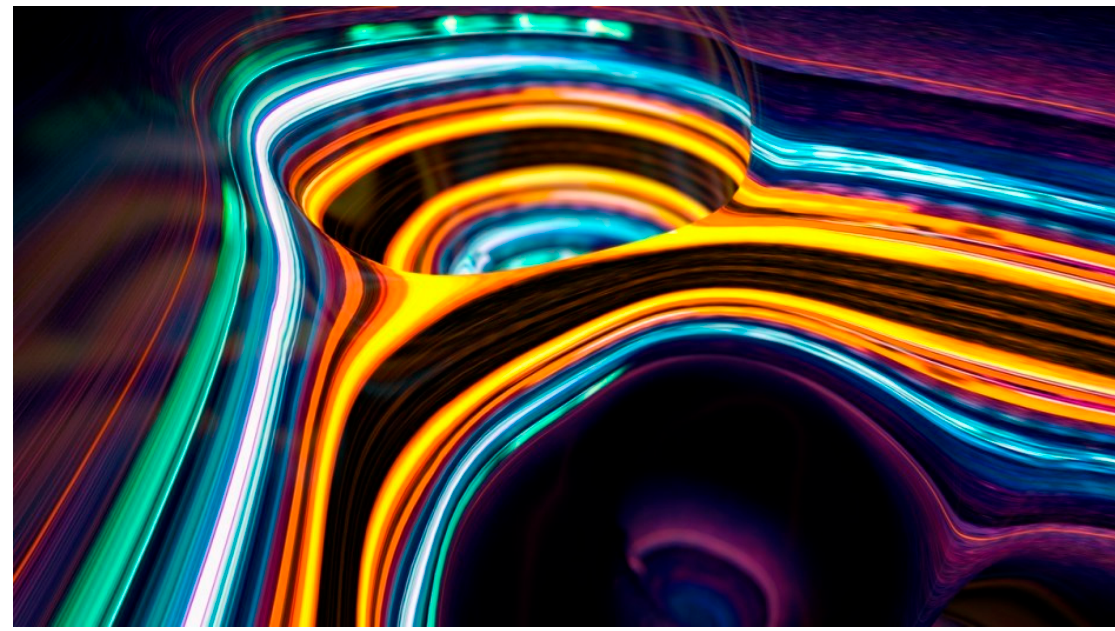
Figure 1. Frame retrieved from the video project made by D. Zakharov, Inside me ,